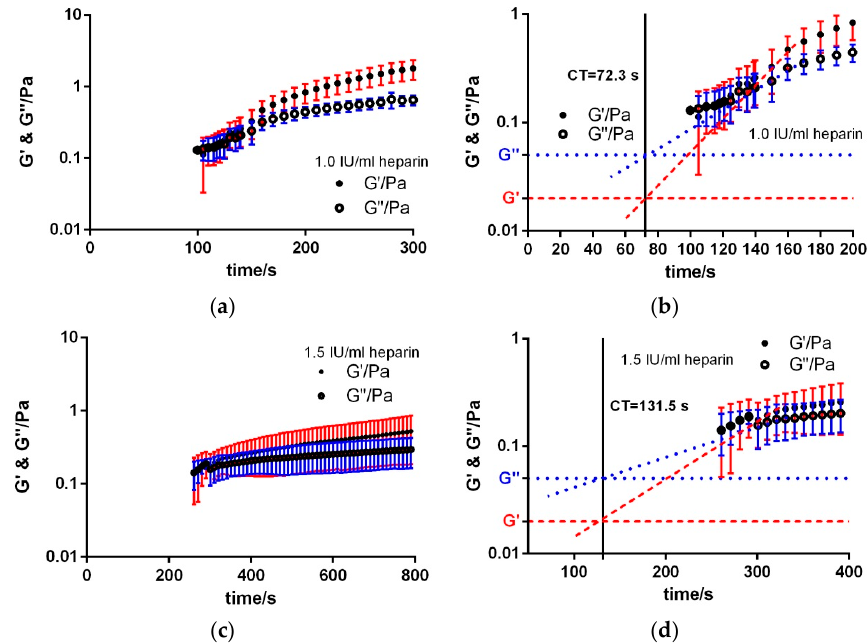
Figure A2. Repeatability measurements of citrated blood with additional heparin activated by Thromborel. Mean elastic and viscous shear moduli of citrated and heparinised ( a ) 1.0 IU/mL ( n = 10 ± SD), ( c ) 1.5 IU/mL ( n = 4 ± SD) blood activated with Thromborel are shown over time. The measurement was performed at a shear stress of 0.04 Pa with 1 Hz and a 1°/40 mm stainless steel cone geometry; ( b , d ) Enlarged parts from diagrams ( a , c ), respectively. The dashed red line at 0.02 Pa visualises the elastic shear modulus and the dotted blue line at 0.05 Pa the viscous shear modulus of uncoagulated citrated blood with no coagulation activator. After the addition of the activator Thromborel the increase of G ′ and G ″ was smaller than without heparin. In comparison to 0.5, 0.8 IU/mL heparin and the reference measurement, the clotting time (CT, black solid line) was further prolonged by 1.0 IU/mL (72.3 s) and 1.5 IU/mL heparin (131.5 s).